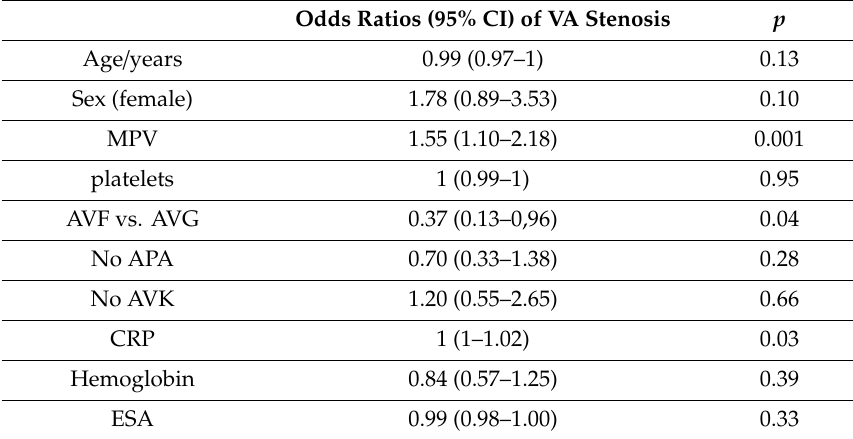
Table 4. Multivariate analysis by the Cox model of vascular access stenosis.